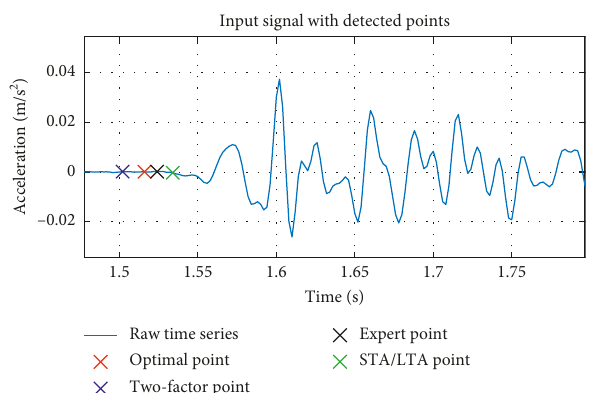
Figure 9: Close-up on arrival time. The time localized manually by the expert: 1.524 (black cross), identified by the STA/LTA method: 1.534 (green cross), and identified with the proposed method:1.518 (red cross). Arrival times given as seconds from the beginning of the